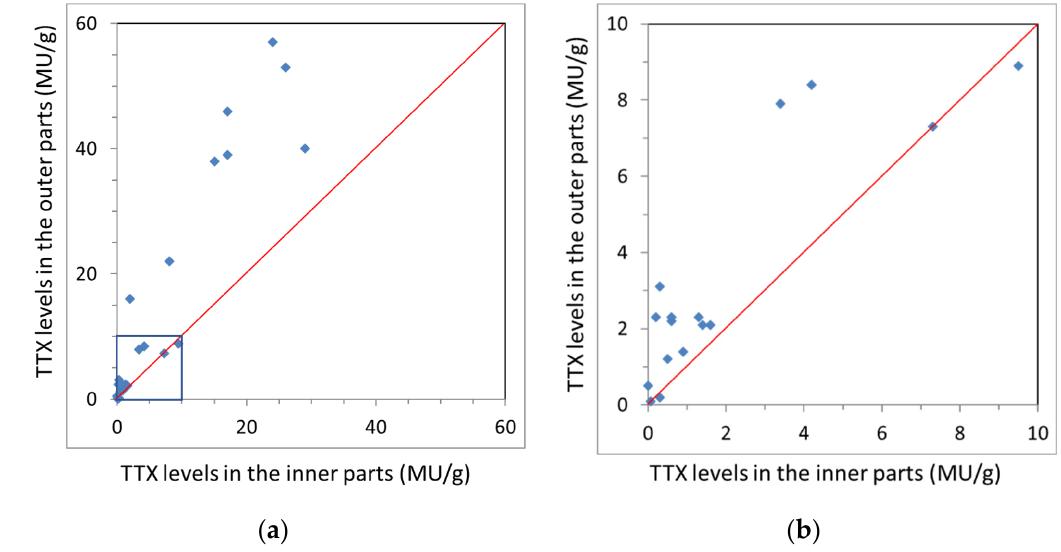
Figure 5. Relationship of TTX levels in the inner and outer parts of flesh of Takifugu flavipterus . ( a ) All specimens and ( b ) the expansion of the square indicated in ( a ). Red line: TTX levels in the outer parts = TTX levels in the inner parts.